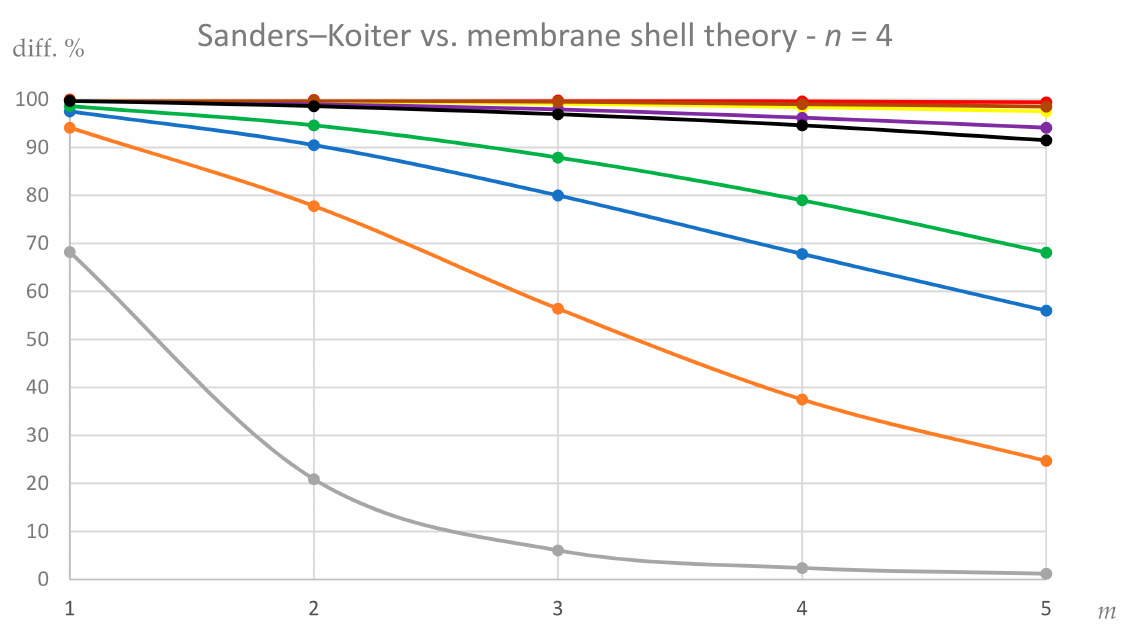
Figure 4. Simply supported DWCNT of Table 1 with different values of aspect ratio L / R 2 and thickness ratio R 2 / h . Shell- like modes ( n = 4). Comparisons between extended Sanders–Koiter and simplified membrane shell theories, where